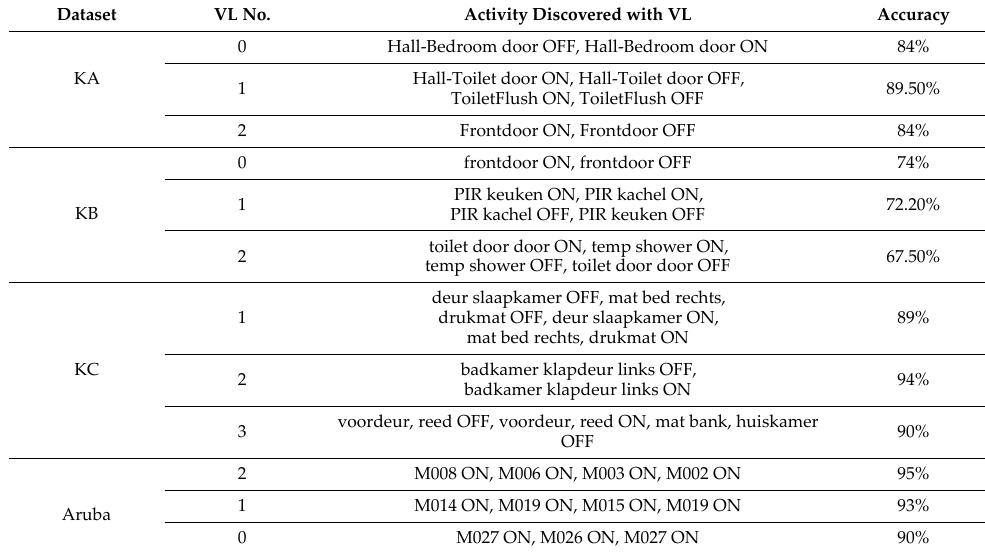
Table 6. Results of activity discovery in each dataset with virtual